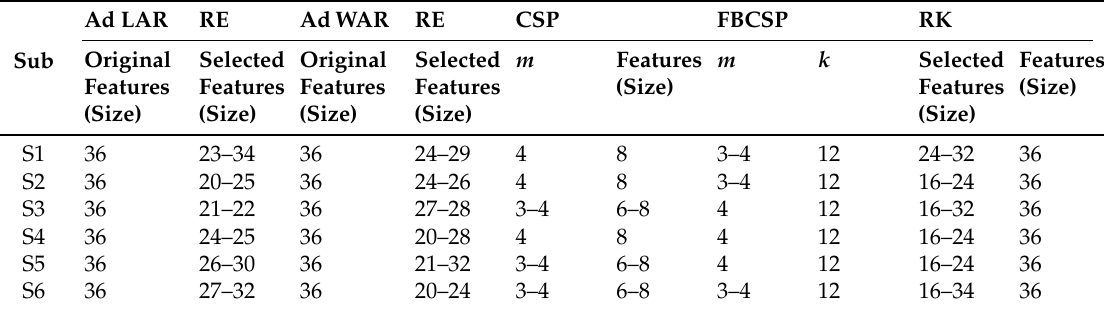
Table 3. Output of the BCIs for the stage of feature extraction and selection, during gait planning recognition.